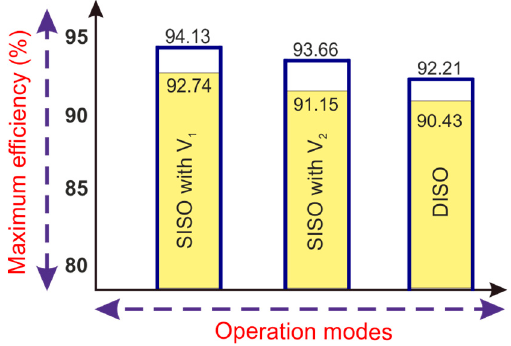
Table 3. Comparison of converters.